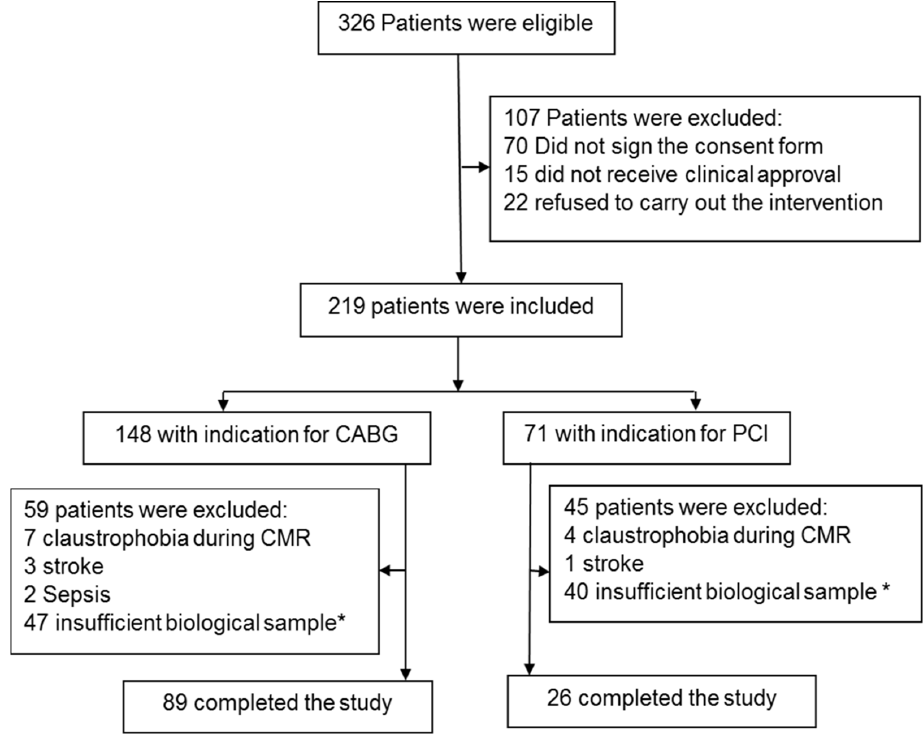
Figure 1. Diagram of the study. *Insufficient blood for sample analysis.